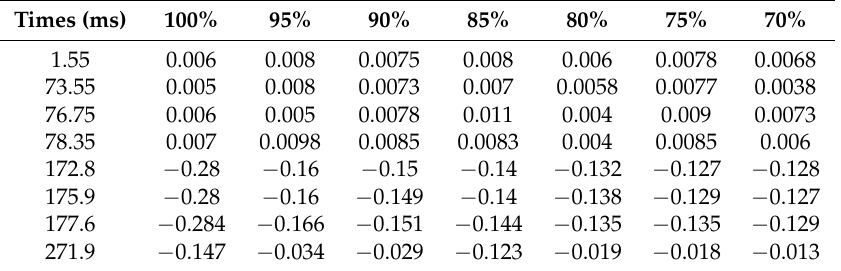
Figure 6. Lead-acid test system. Table 4. Training data